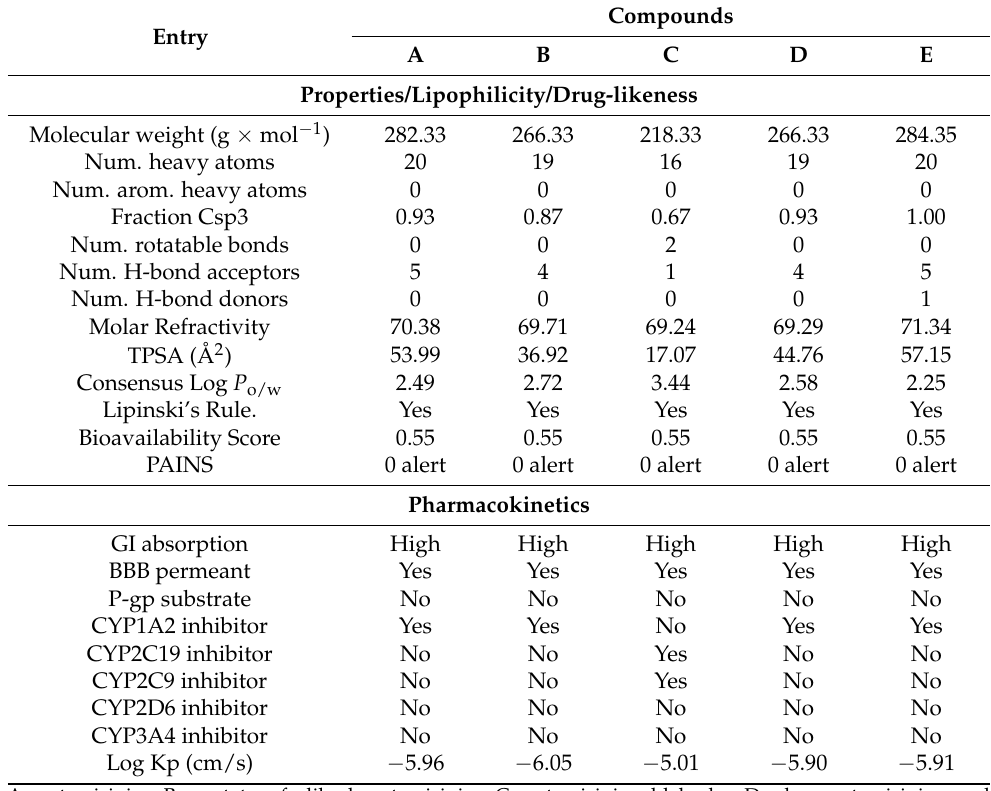
Table 1. Absorption, distribution, metabolism, excretion, and toxicity (ADMET) properties of Artemisinin and its selected derivative compounds.